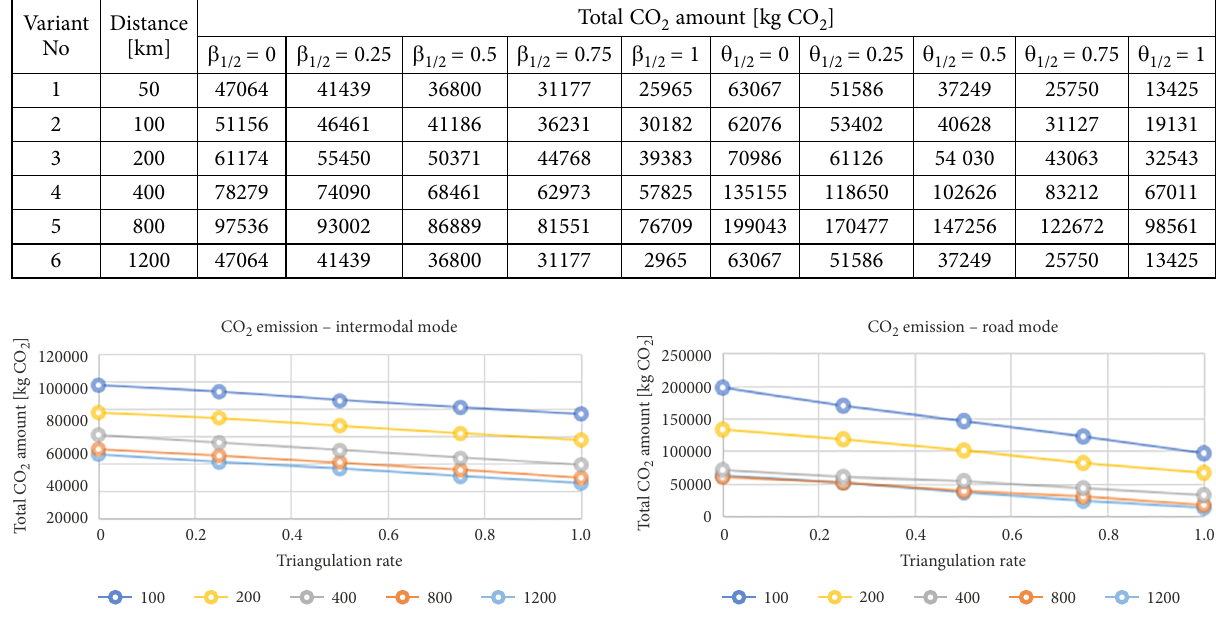
Figure 6. Regression of CO 2 emission in relation to triangulation value Table 5. Carbon emission in relation to changeable